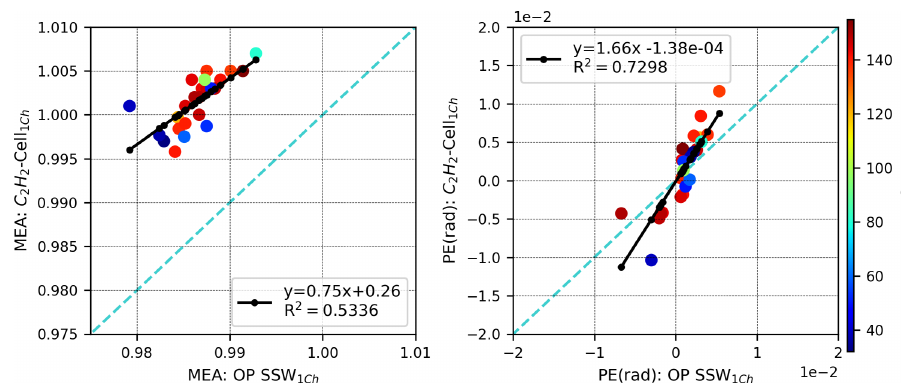
Figure 18. Correlations between the MEAs obtained with the OP and cell methods for the first channel.